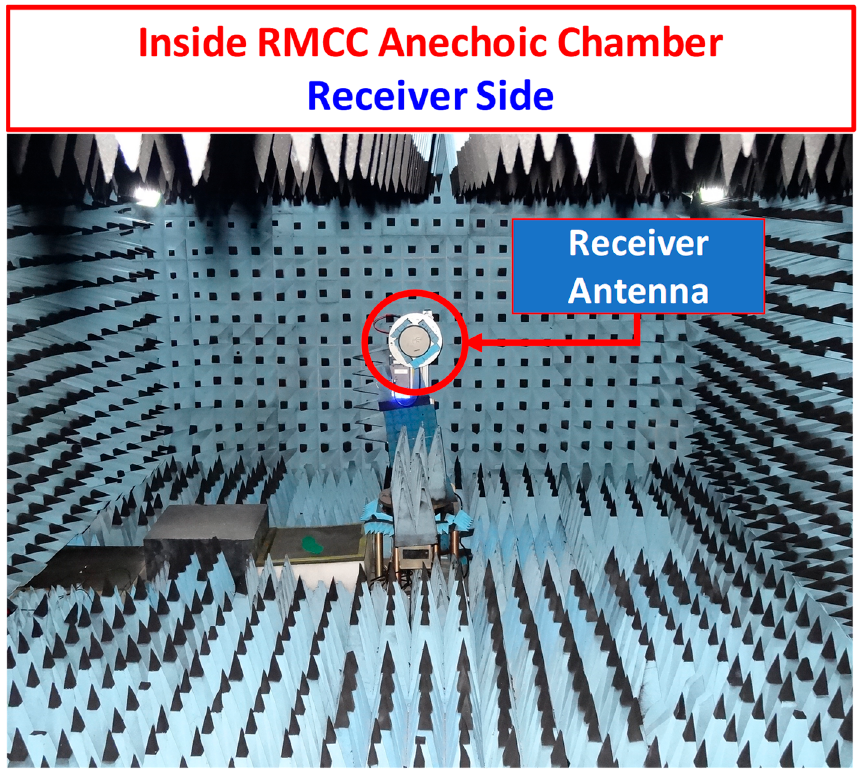
Figure 9. Receiver Antenna Inside the Chamber Room.